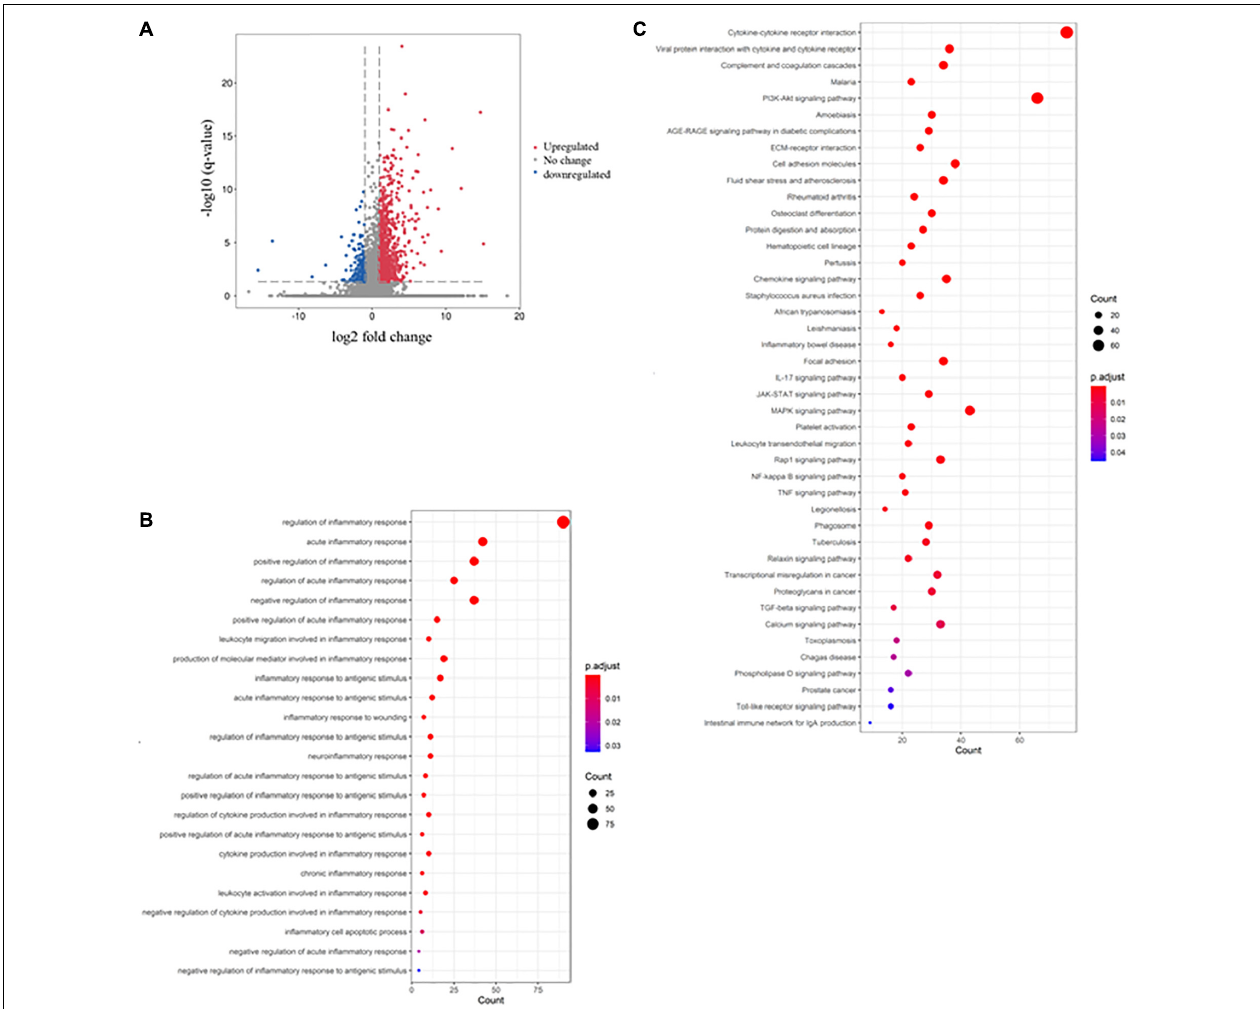
FIGURE 1 | Dextran sulfate sodium (DSS) induced colitis through the induction of inflammatory response. The volcano plot shows the differential expression of genes in the gut of DSS-induced colitis mice. The genes with | log 2 (fold change: DSS/Ctrl)| > 1 and -log B and H corrected p -value > 1.3 were considered differentially expressed genes (DEGs). The red dot represents upregulated genes, the green dot represents downregulated genes, and the gray dot represents genes with no significant change. (B) The rich factor plot shows the alteration of biological processes related to immunity in the gut of DSS-induced colitis mice. The size of the dot represents the number of DEGs. The color intensity of the dots represents the significance of the biology processes. (C) The rich factor plot showed the alteration of cell signaling pathways related to immunity in the gut of DSS-induced colitis mice. The size of the dot represents the number of DEGs. The color intensity of the dots represents the significance of the signaling